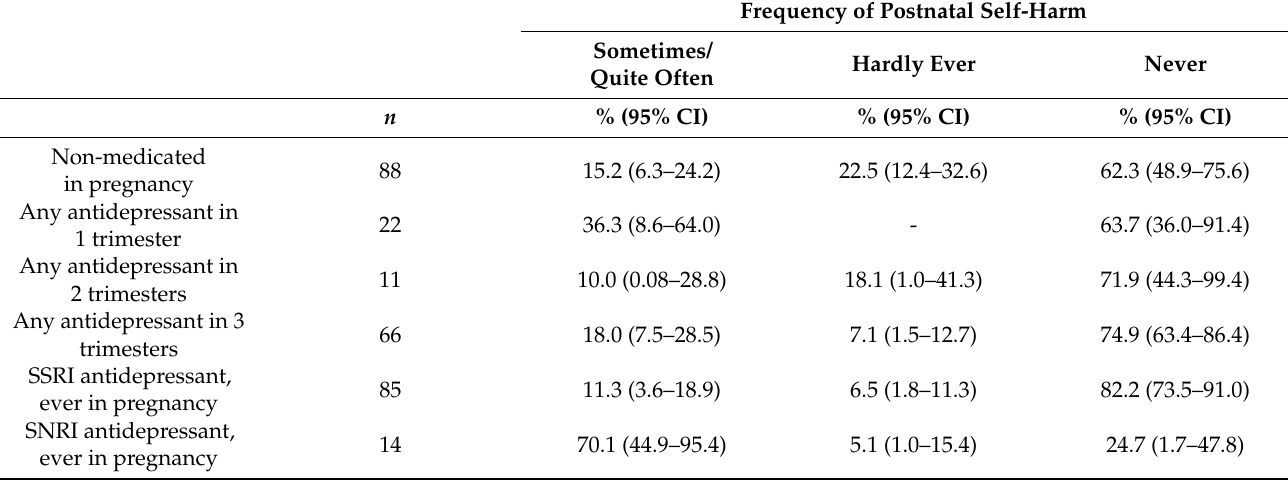
Table 2. Weighted proportion of frequency of postnatal self-harm according to past antidepressant treatment in pregnancy, by duration and class ( n = 187) 1 .